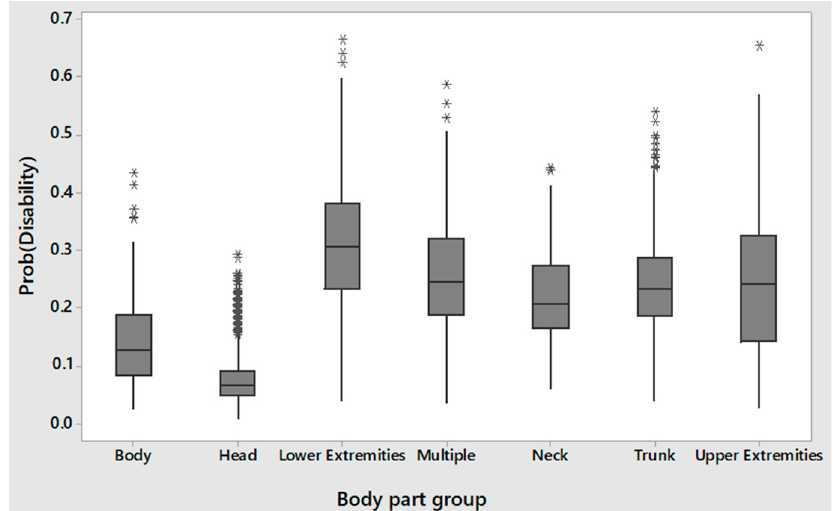
Figure 2. Boxplot of disability post-incident state for each body part group. (* shows the outlier data points).